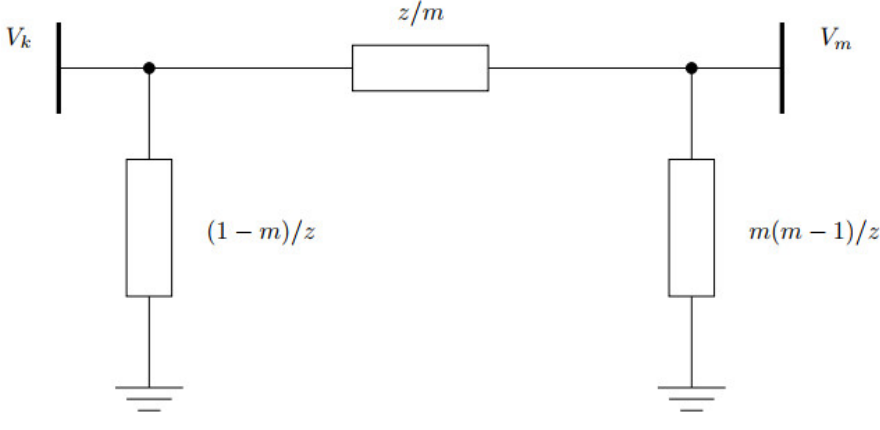
Figure 10. A two-winding transformer’s equivalent.